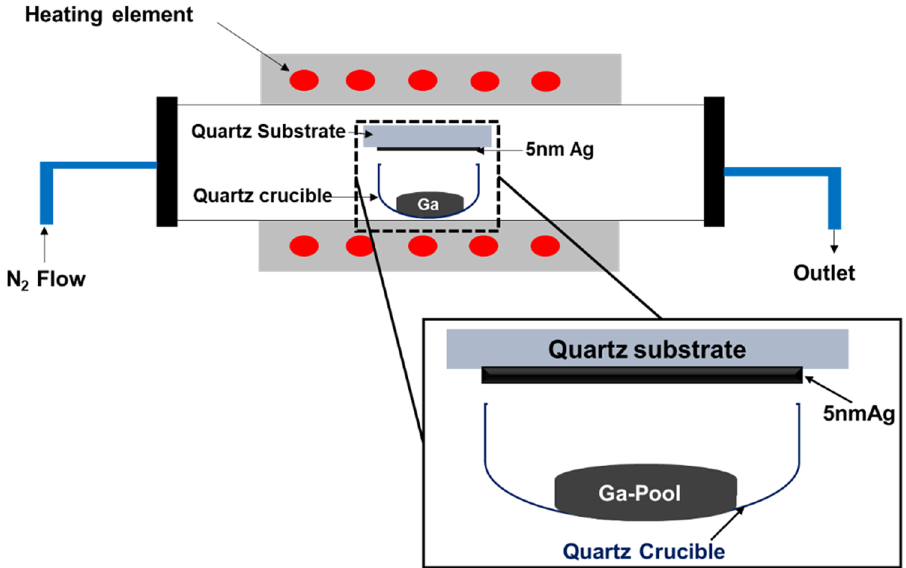
Figure 1. Schematic illustration of the UV photodetector fabrication